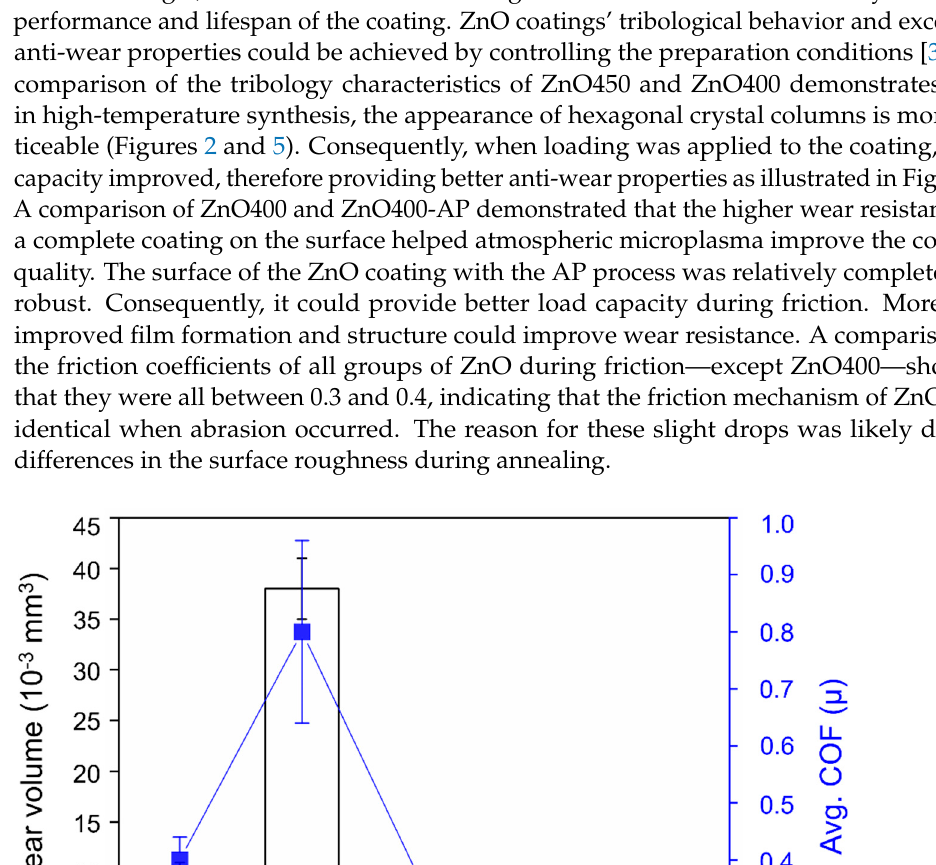
Figure 8. Comparison of transmittance of ZnO400-APA and ZnO400-AP.